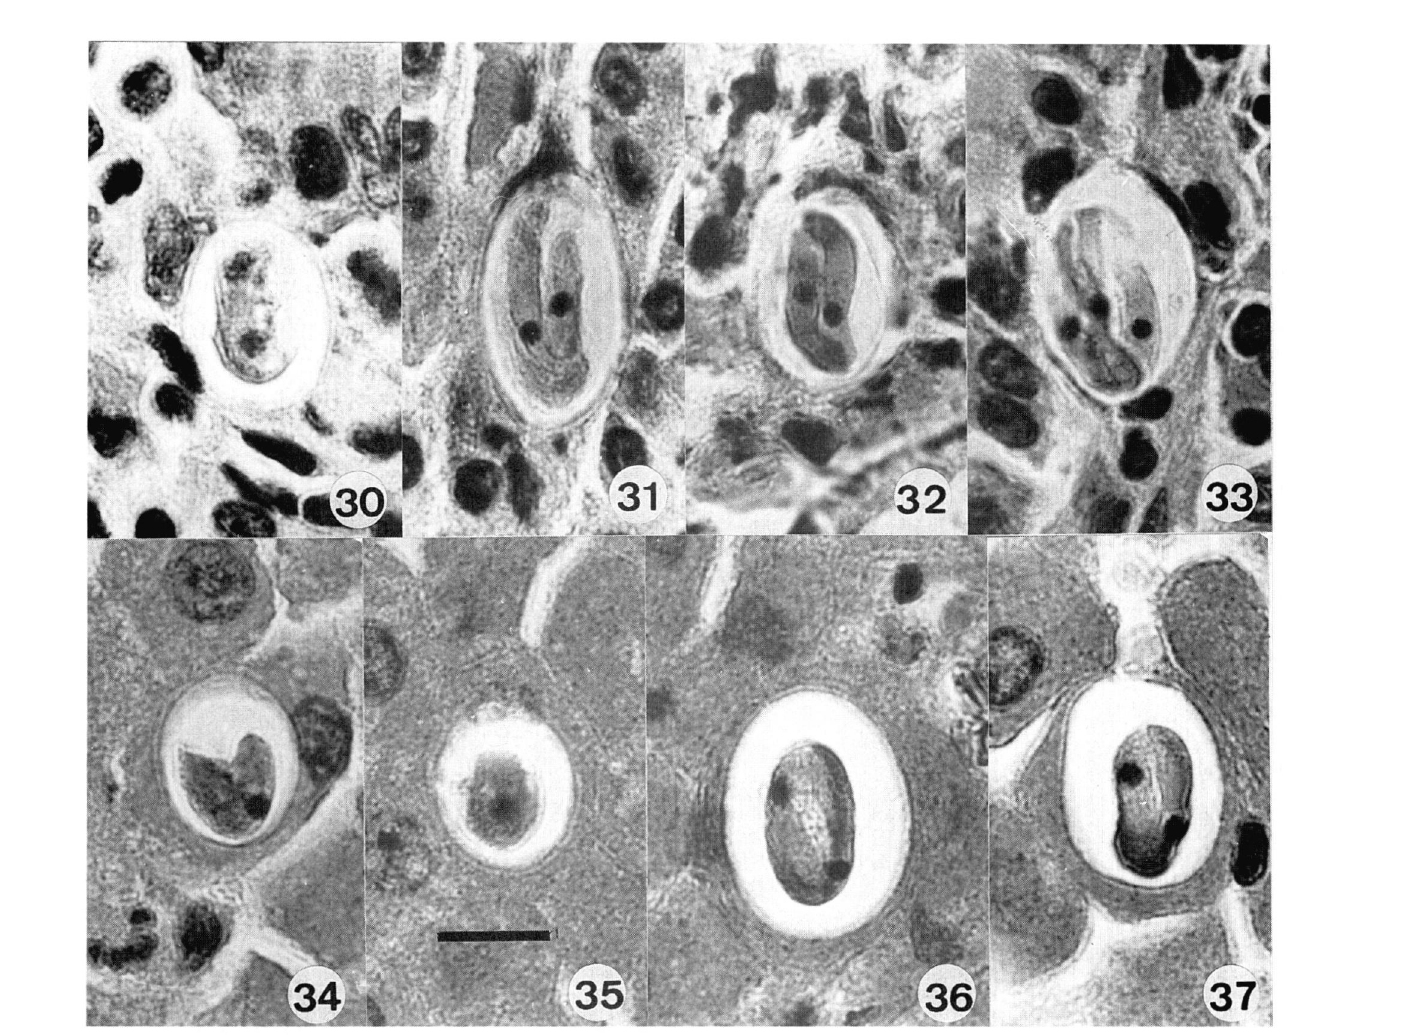
Figs 30-33- - Developing tissue-cysts of an unidentified protozoan (probably Hepatozoori) in the lamina propria of the small intestine of the bat Peropteryx macrotis, containing from 2-4 endozoites. Figs 34-37. - Similar cysts in the parenchyma cells of the liver. Sections stained with haematoxylin and eosin. Bar = 10